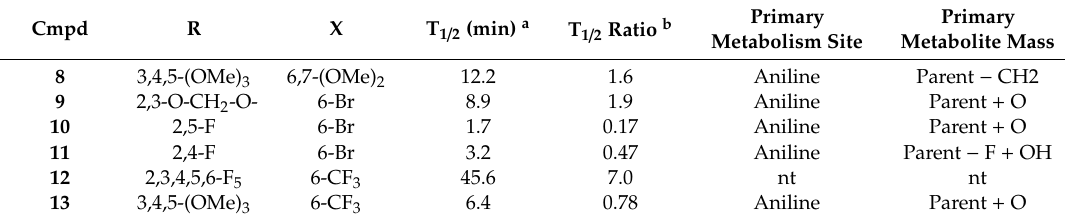
Table 1. Initial microsomal stability assessment (see Supplementary Materials for details).